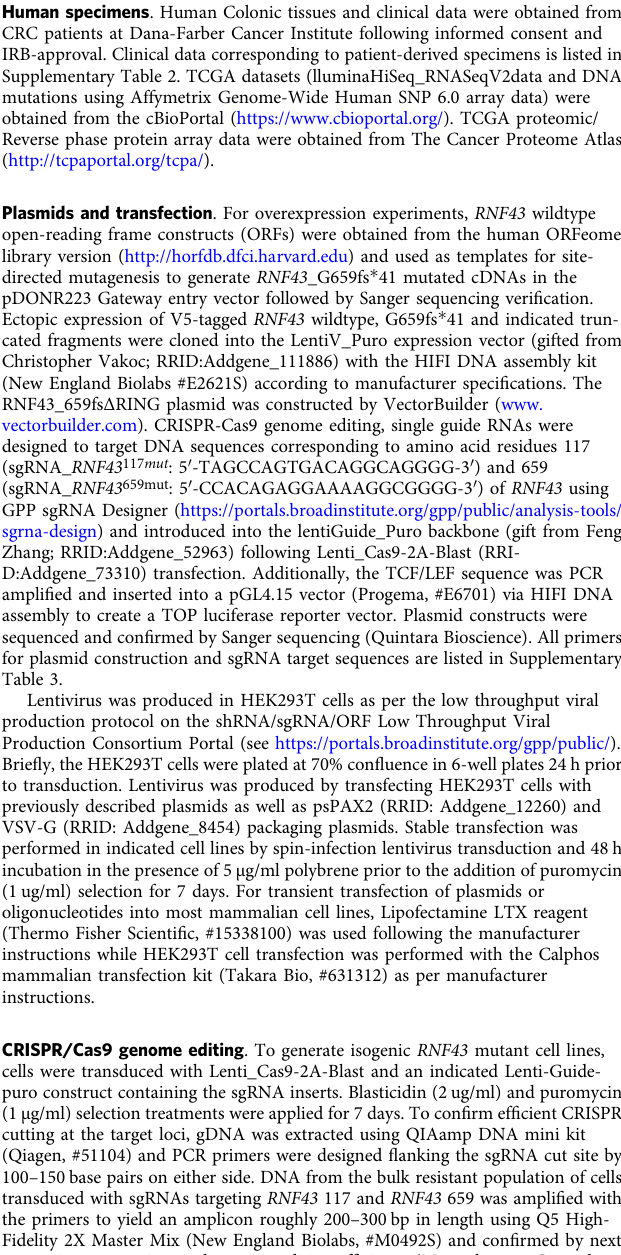
embedded in Matrigel (Corning #356231). After Matrigel solidi fi cation for 10 min at 37 °C, cells were cultured in human intestinal organoid medium composed of IntestiCult ™ Organoid Growth Medium (STEMCELL Technologies, #06010) with 100 U/ml penicillin-streptomycin (Thermo Fisher Scienti fi c, #15140122) and supplemented with Y-27632 for 48 h after establishment or passage. Con fl uent organoids were passaged by incubating in Gentle Cell Dissociation Reagent (STEMCELL Technologies, #100-0485). Organoids were resuspended in a 1:1 mixture of Matrigel and basal media composed of DMEM/F12 (Thermo Fisher